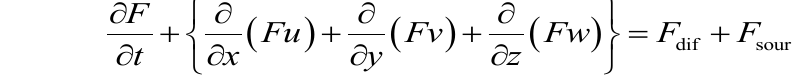
Figure 2. The first sampling point was the raw seawater in the storage tank of the STF. In the second sampling point, seawater that had been filtered by the multimedia filter of the STF was collected. The last six sampling points were located inside the canal and included the two inflow areas of the filtered seawater. They are the traffic bridge (SP#9), the two walking bridges across the canal (SP#6 and SP#8), the two input points (SP#5 and SP#7), and an output point of seawater (SP#10). To